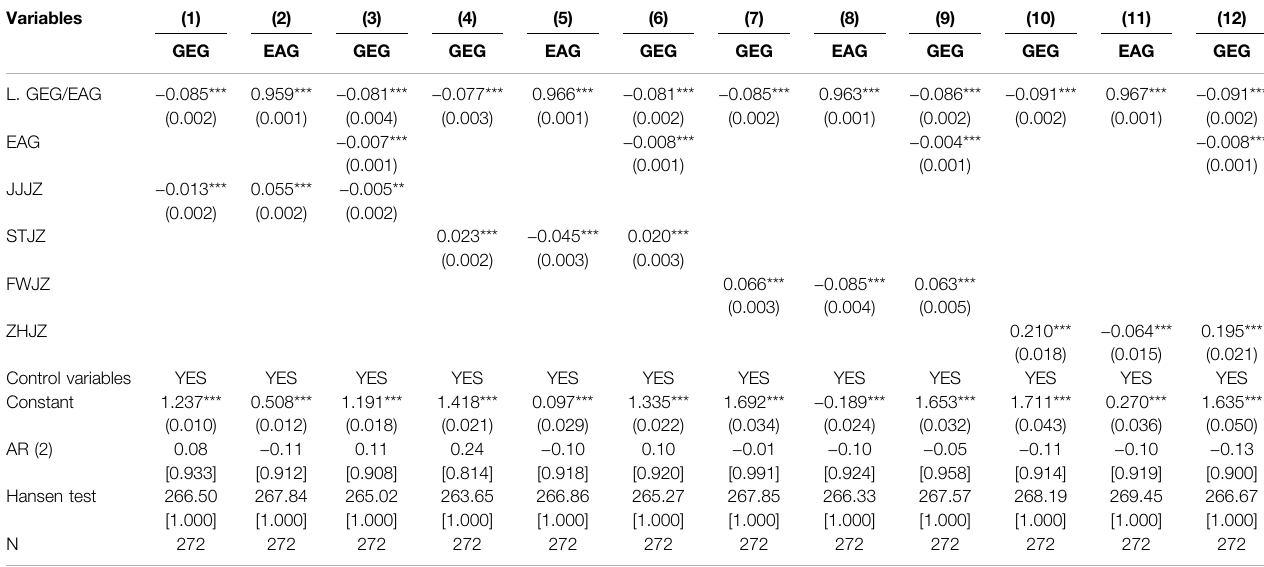
TABLE 5 | Role mechanism of economic agglomeration results.